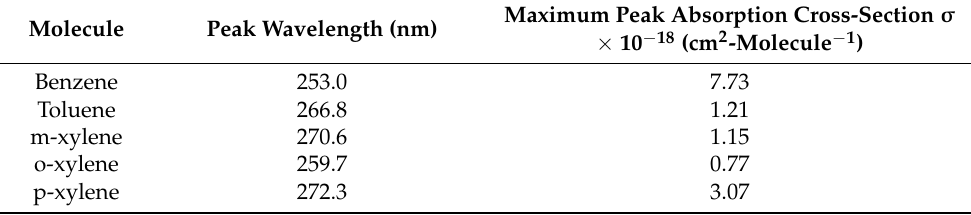
Table 1. Maximum peak absorption cross-section σ of Benzene, Toluene, Ethylbenzene, and Xylenes (BTEX) components at the corresponding peak wavelengths [18].